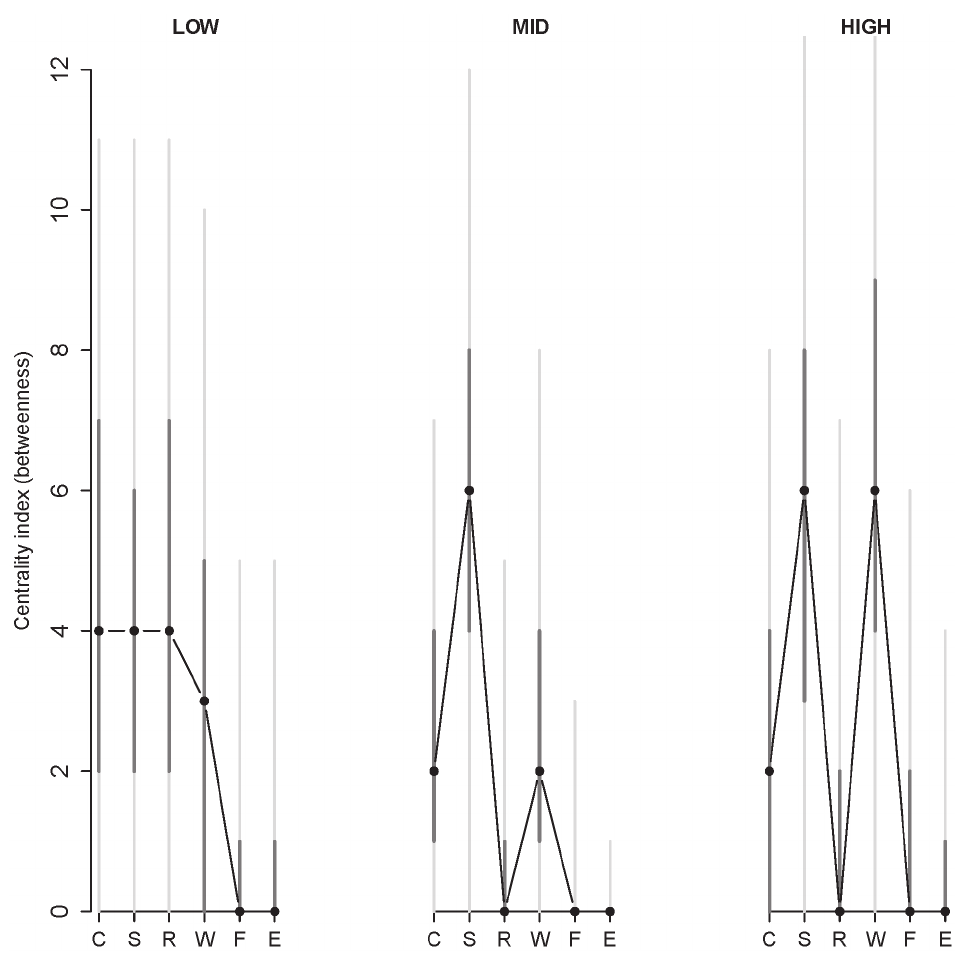
Figure 4. Centrality (betweenness) of each item in the network as a function of level of neuroticism at baseline. Low, mid, and high neuroticism are shown from left to right. The labels of the items are abbreviated by their first letter (C=cheerful, S=sad, R=relaxed, W=worry, F=fearful and E=event). The black dots are the model-based estimate of betweenness, the darkgrey vertical lines represent 50% confidence intervals and the light grey vertical lines represent 95% confidence intervals (as estimated from the bootstrap method). Together, the median, 50% and 95% confidence intervals give information on how the node centrality for every item in all three networks is distributed. Individual differences. In the right panel of Figure 5 the correlation between the connection strengths of the links of the main inter-individual differences network and the links of the corresponding validation network is shown. The product moment correlation between the connection strengths of the two networks is a sizeable correlation of 0.50 ( p = 0.01; rank order correlation is r = 0.56, p = 0.004). This indicates that although some links in the inter-individual differences networks differ between the two datasets, the majority of them reflect a similar degree of individual variability. We refer again to Appendix S3 for a visual illustration of the individual differences networks in both datasets.